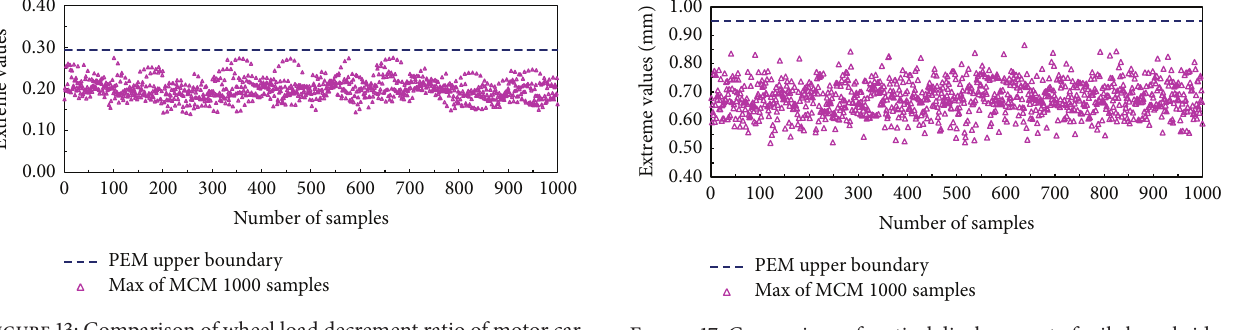
Figure 17: Comparison of vertical displacement of rail above bridge midpoint.